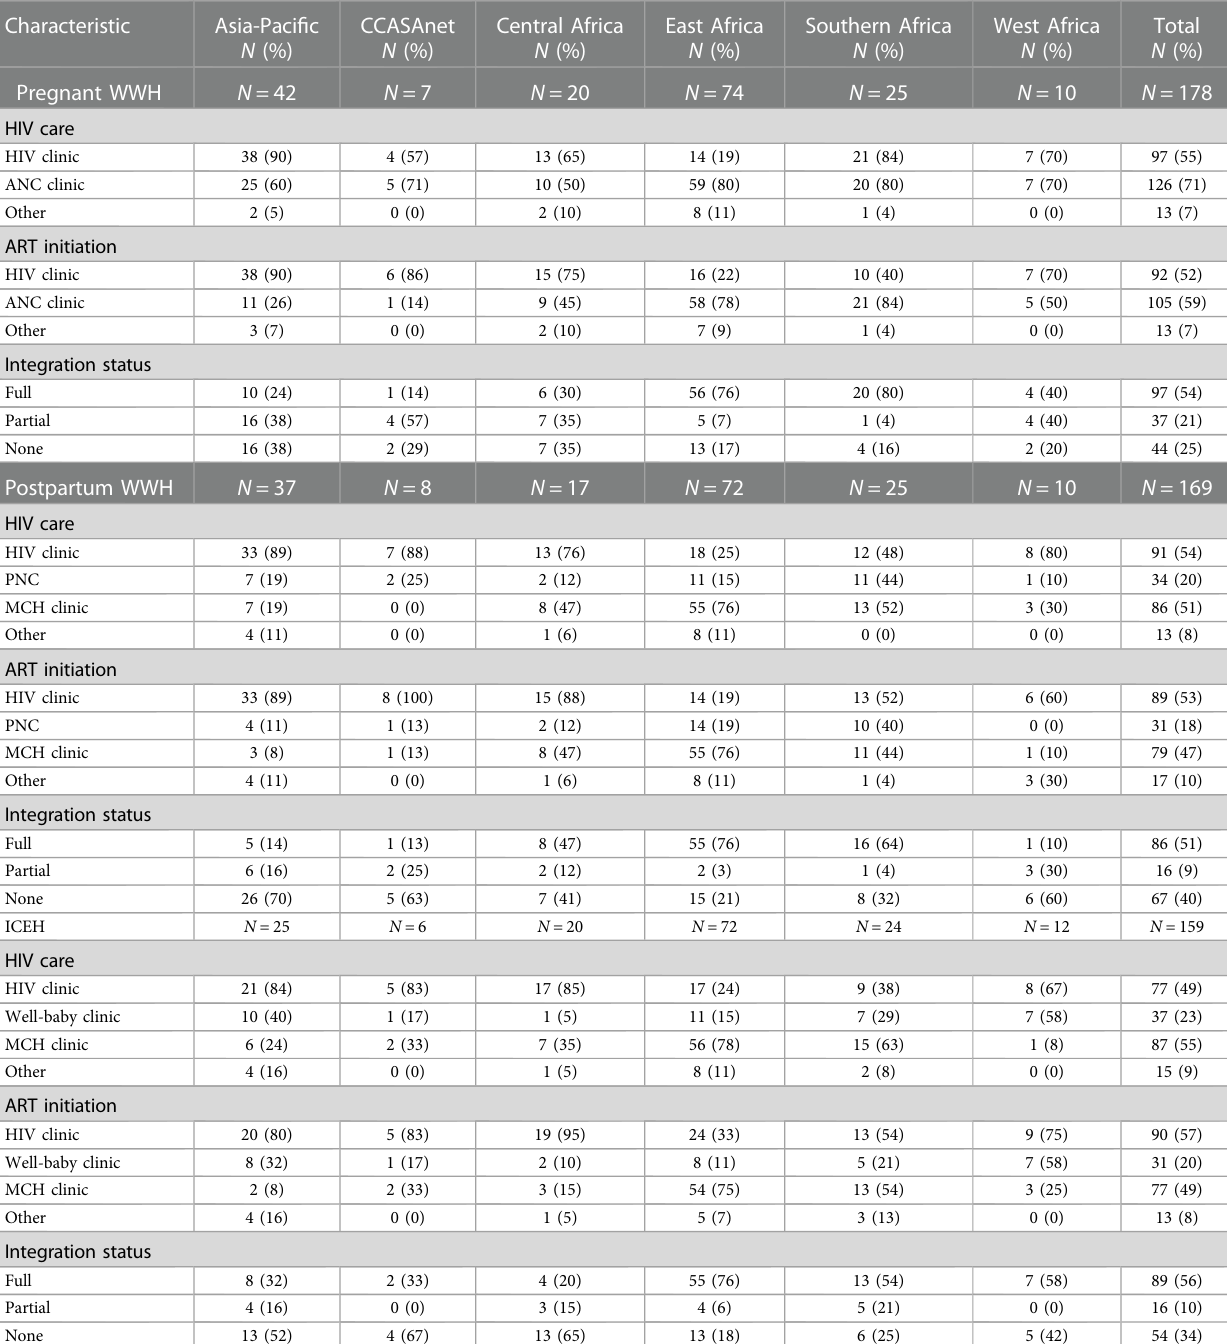
TABLE 2 Integration of HIV and maternal and child health services, by IeDEA region, September 2020 to March 2021.